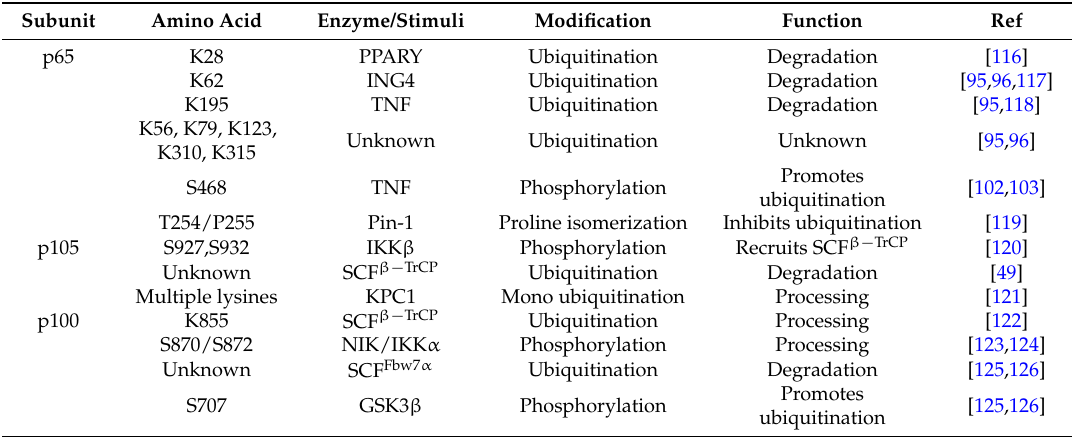
Table 1. List of posttranslational modification associated with the ubiquitination of NF- κ B